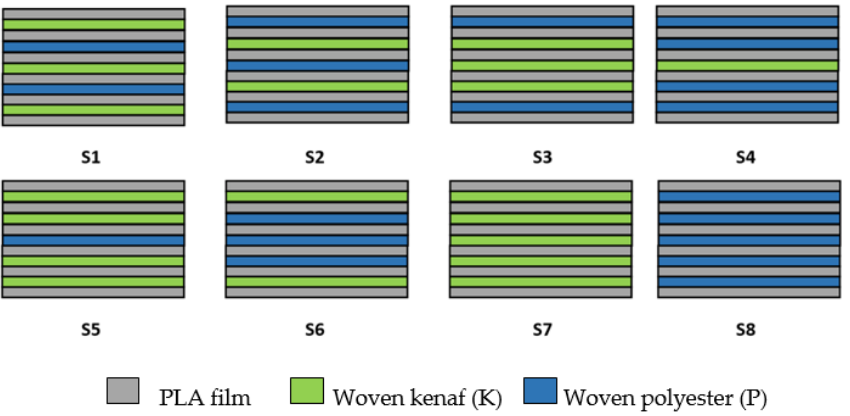
Figure 1. Stacking sequences and fiber content of laminated composites.